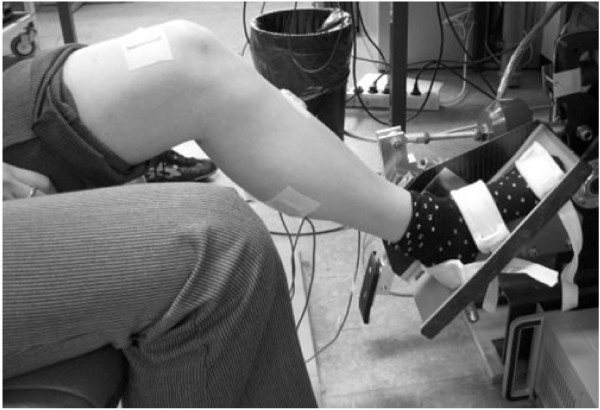
Measurement set-up. The subject's ankle was fixated on the footplate that was rotated by an electrically powered single axis actuator. Ankle reaction torque, ankle angle and EMG were measured during imposed ramp-and-hold movements.